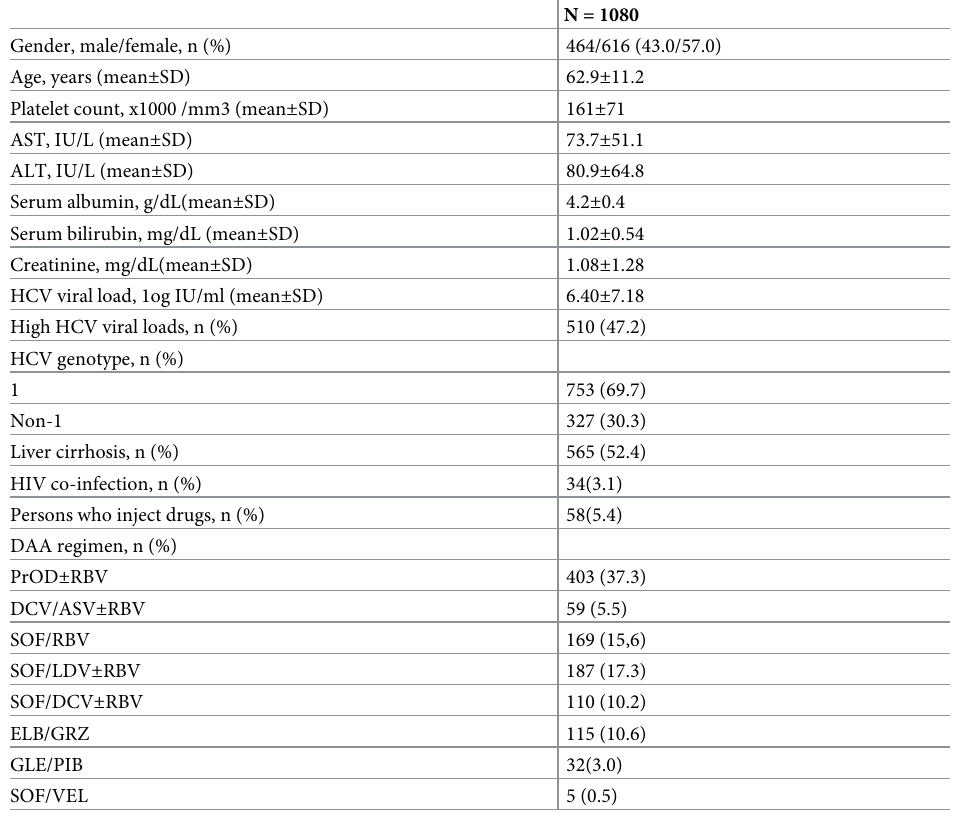
Table 1. Basic characteristics and treatment regimens of the